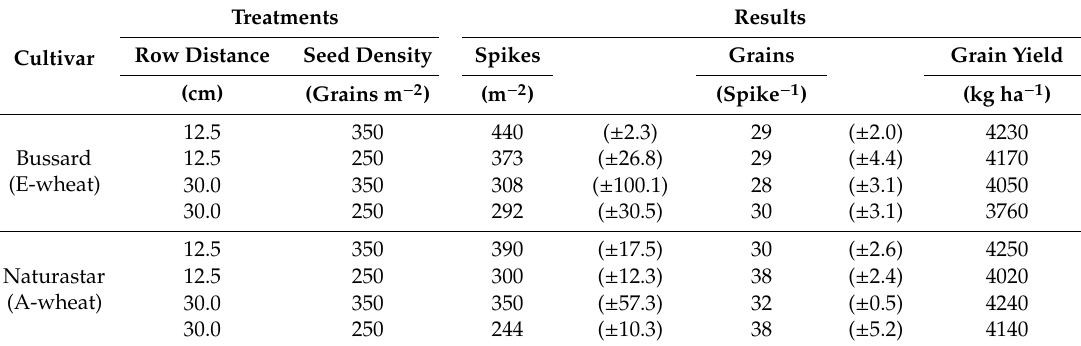
Table 4. Results of yield components (spikes m − 2 & grains spike − 1 ) of the di ff erent treatments ( n = 24). Treatments Results Row Distance Seed Density Spikes Grains Grain Yield Cultivar (cm) (Grains m − 2 ) (m − 2 ) (Spike − 1 ) (kg ha − 1 ) Bussard (E-wheat)